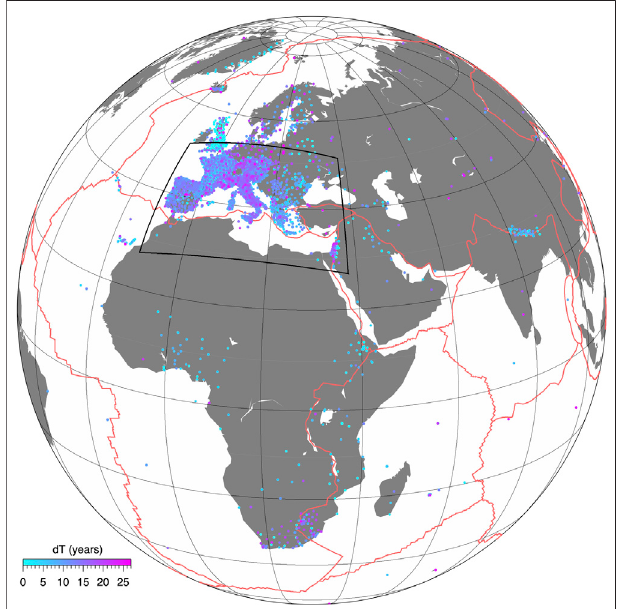
FIGURE 1 | Distribution and observational time-span of the GNSS stations analyzed. The black box shows the Euro-Mediterranean region for which we derive the strain-rate map, and where the analysis center described in this work focuses the most. The red lines show major plate